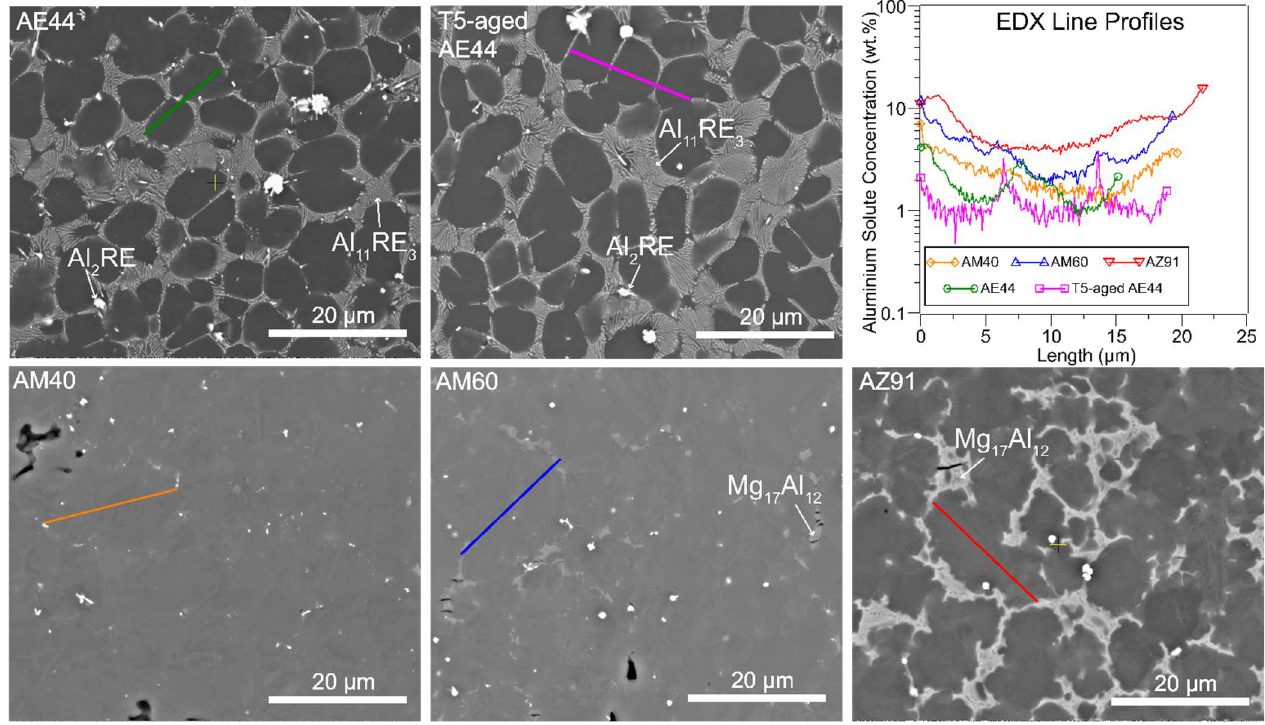
Figure 7. Backscattered SEM micrographs and EDX line profiles of the α-magnesium matrix.